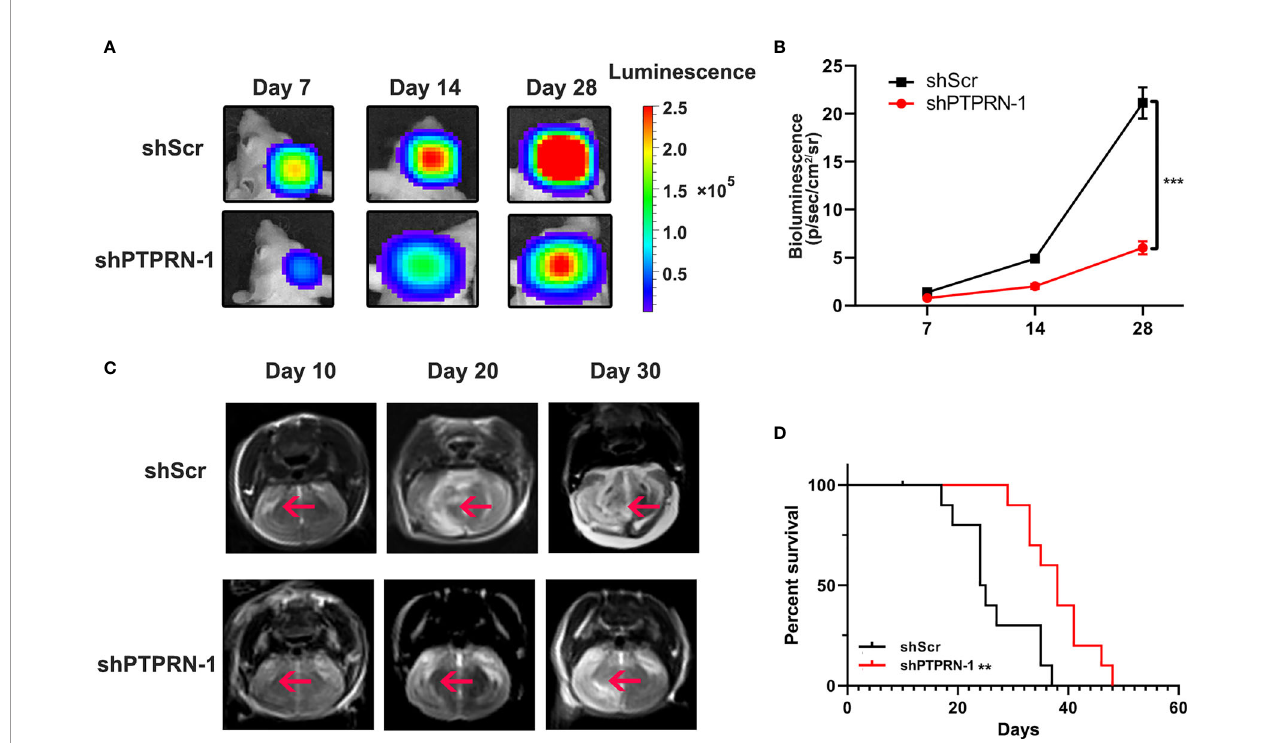
FIGURE 5 | PTPRN knockdown decreased tumor growth in a mouse xenograft model. (A) Representative image of the tumor volume measured by bioluminescence imaging; (B) The intensity of fl uorescence penetration into the brain tumor; (C) Representative image of the tumor volume measured by MRI; (D) Survival analysis of PTPRN expression in 12 intracranially implanted nude mice; Kaplan-Meier survival curves were used to analysis the difference of prognosis between the control group and PTPRN knockdown group; **p < 0.01, ***p <